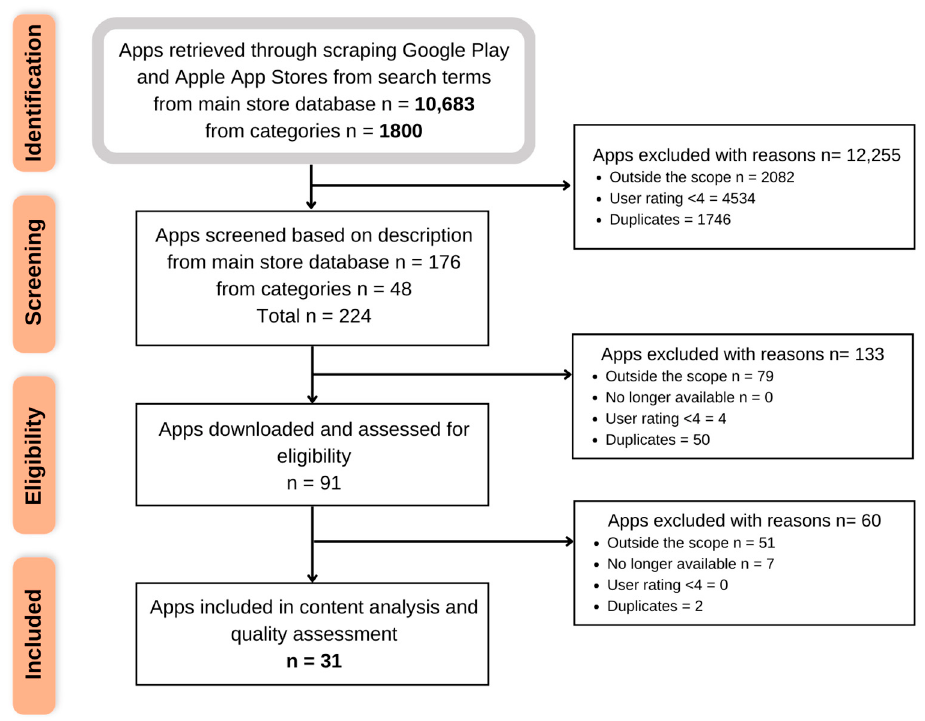
Figure 1. App selection flowchart. Out of the 12,483 pregnancy apps identified, 31 were included for content analysis and quality assessment.